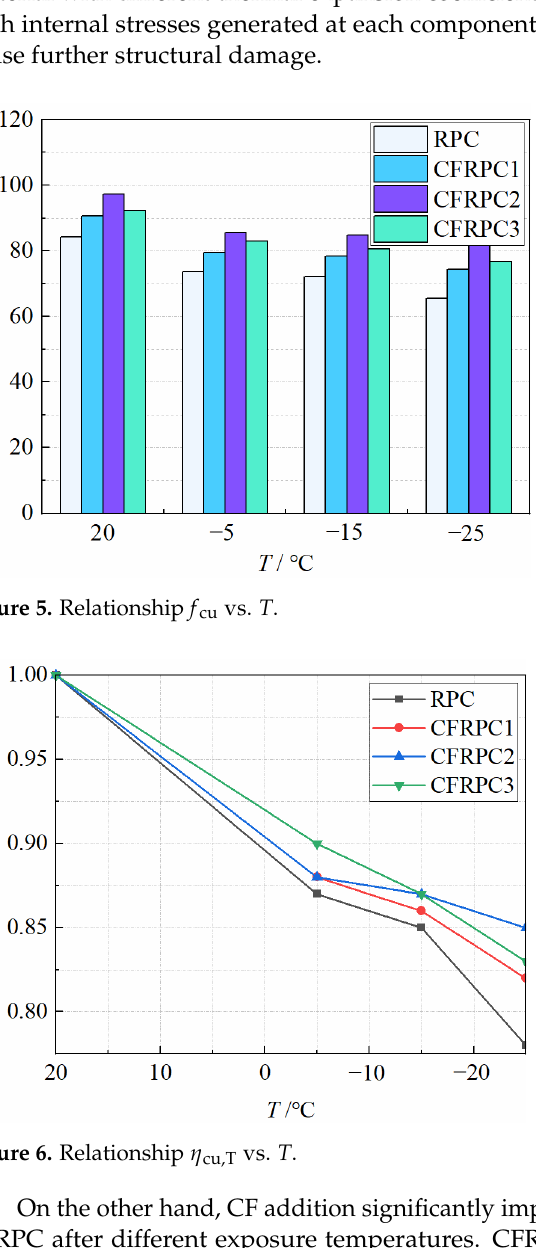
Figure 6. Relationship η cu,T vs. T.